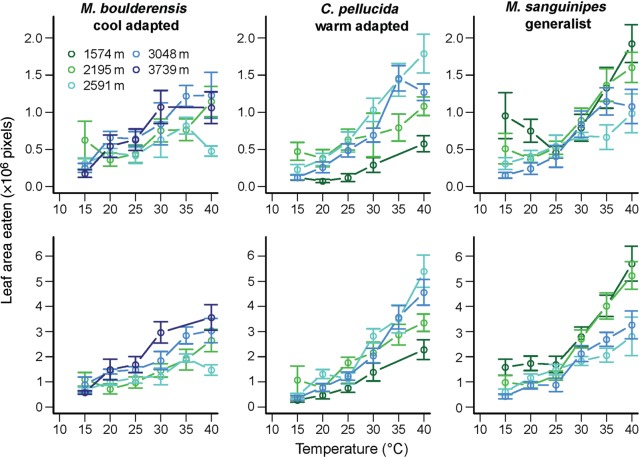
Grasshopper feeding rates (×106 pixels) over a 2 (top panels) or 8 h period (bottom panels) as a function of temperature (in degrees Celsius) for field-collected grasshoppers. Mean values ± SEM are depicted, with colours distinguishing sites.